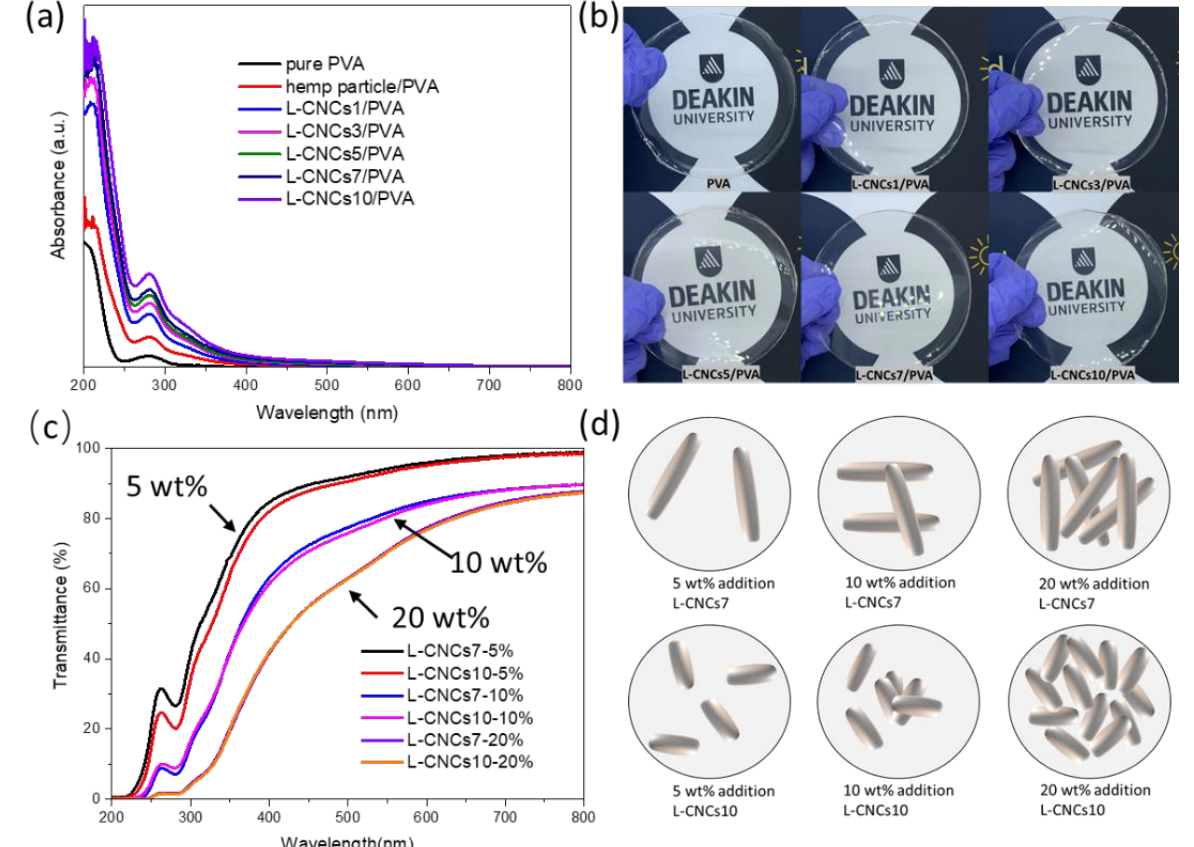
Figure 7. ( a ) Absorption spectra of pure PVA, hemp particle/PVA, and L-CNCs/PVA films (5 wt. %), ( b ) digital images of pure PVA and L-CNCs/PVA films (5 wt. %), ( c ) transmission spectra of L-CNCs7(10)/PVA at 5 wt. %, 10 wt. %, and 20 wt. % ratio and ( d ) Schematic diagram of L- CNCs’ distribution in PVA film.